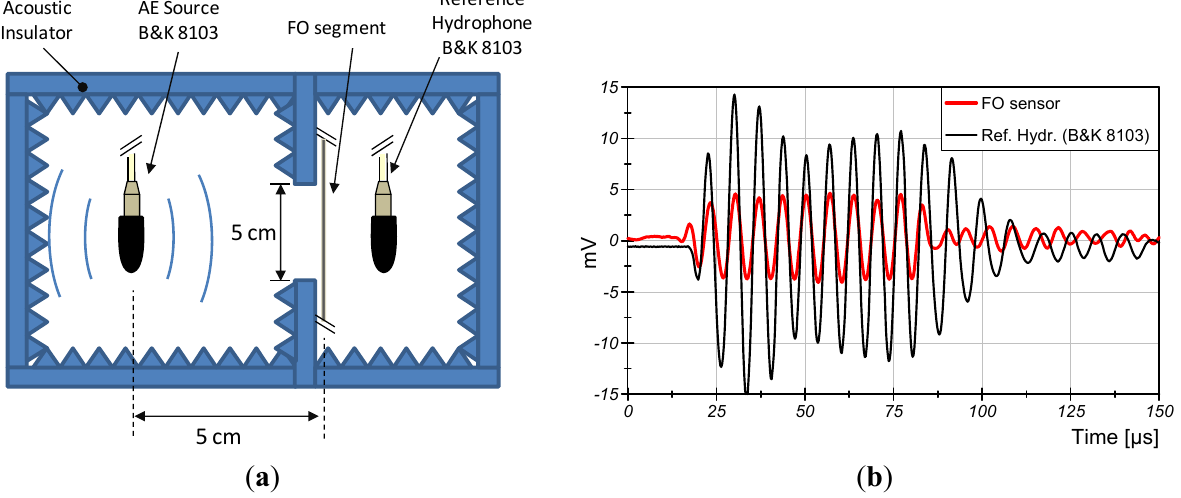
Figure 1. ( a ) Experimental set-up for the measurement of fiber sensitivity; ( b ) The same AE detected with the FO segment and the calibrated